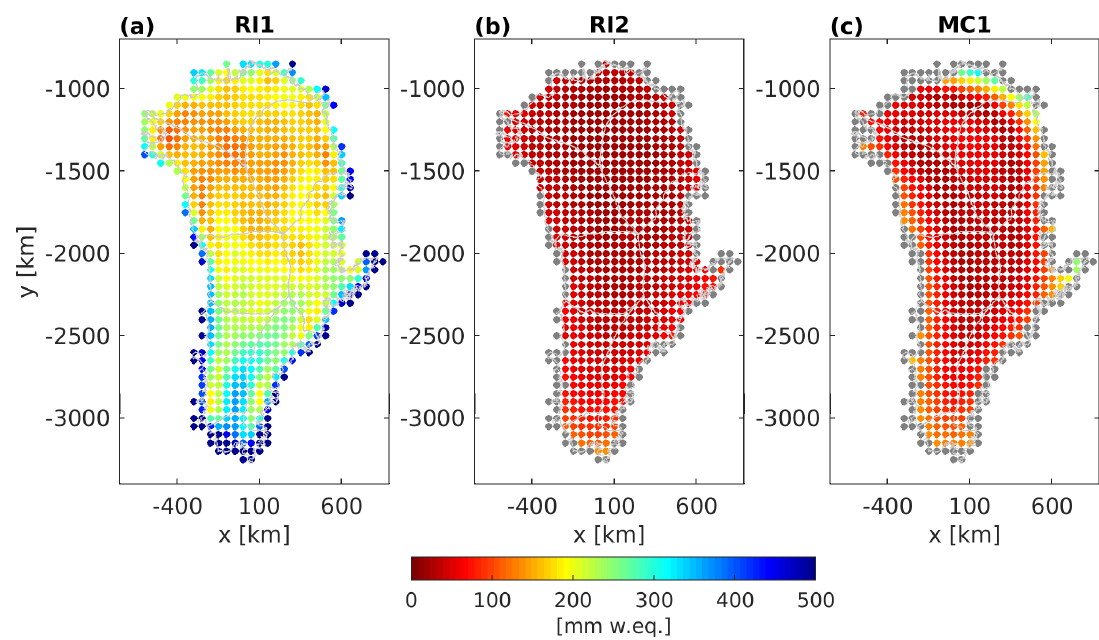
Figure 14. Noise level, given in terms of the scaled standard deviation of the noise time series, estimated from the gridded mass changes. Panels ( a – c ) show results from different groups (Table 3). Grid cells in grey lie outside of the original grid